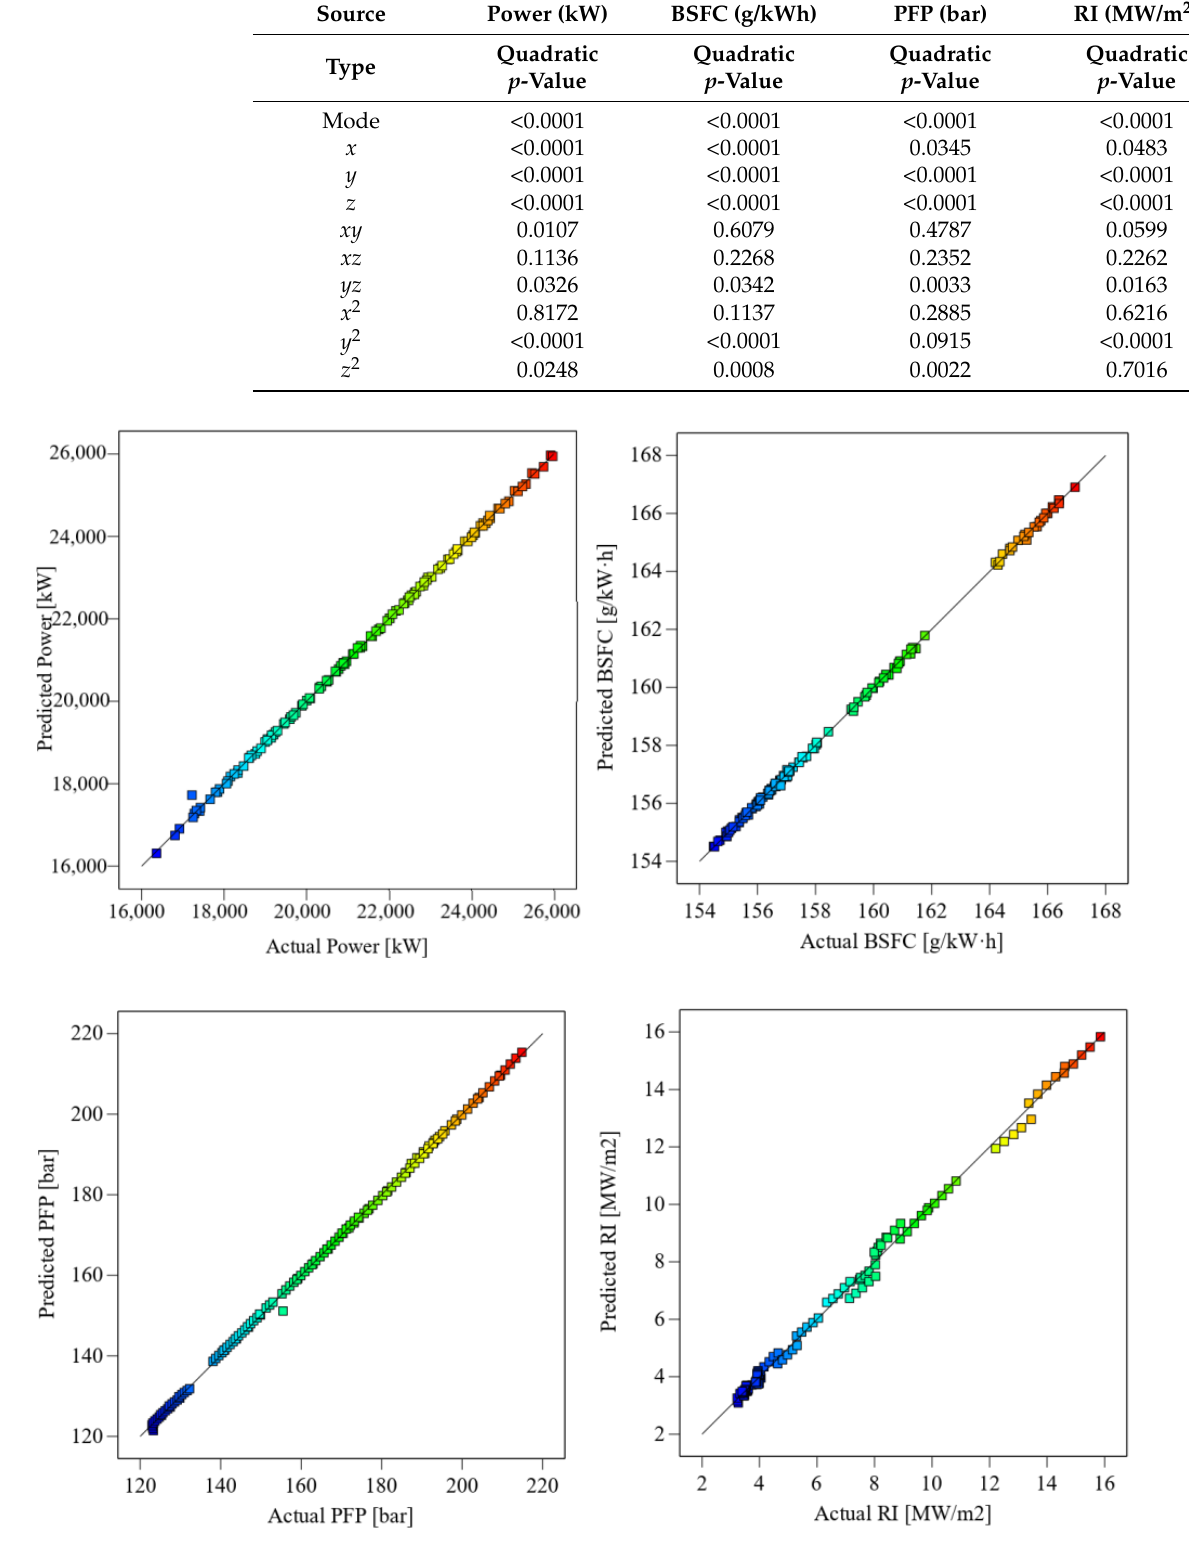
Figure 6. Influence trend of different parameters on combustion.